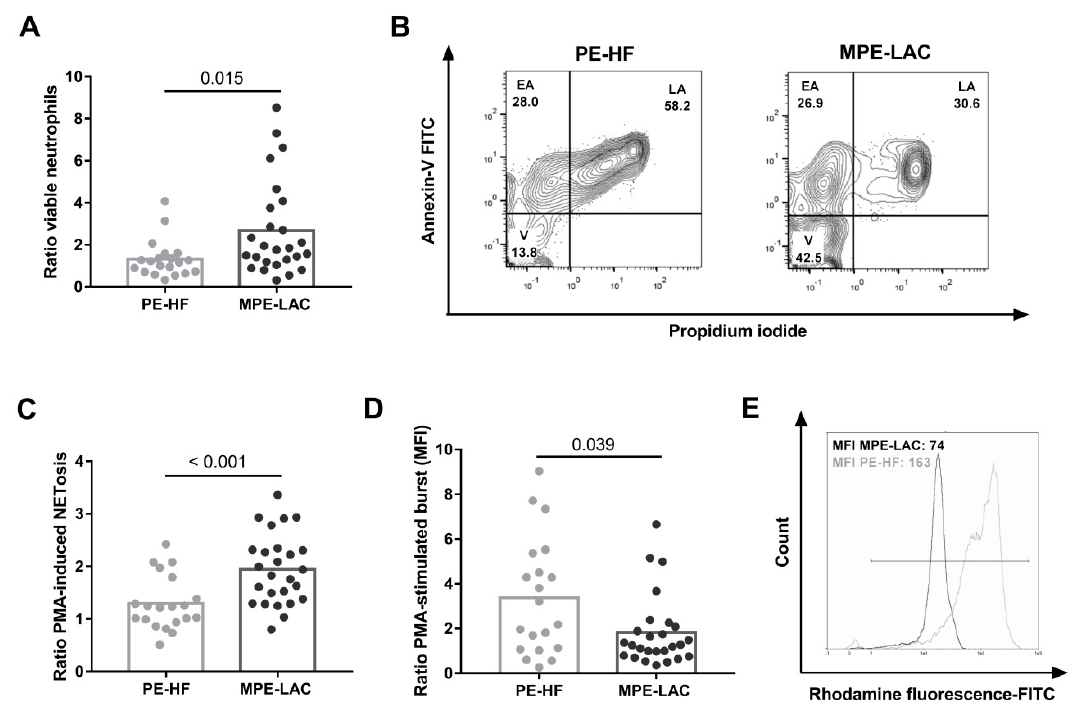
Figure 2. Effect of cell-free pleural fluid on neutrophil viability, NETosis, and oxidative burst. Healthy neutrophils were cultured in the presence of pleural fluids (25% of volume). Viability and oxidative burst capacity were determined by flow cytometry and NET formation was measured by fluorescence. ( A ) The viability of neutrophils in the presence of pleural effusions from heart failure (PE-HF) ( n = 20) and lung adenocarcinoma (MPE-LAC) ( n = 26). Data were expressed as ratios cal- culated by dividing PE-HF or MPE-LAC values by their respective medium values. ( B ) Representa- tive flow cytometry plots of apoptosis assay of neutrophils cultured with cf-PE-HF and cf-MPE- LAC. Quadrants are V for viable cells, EA for early apoptosis, and LA for late apoptotic cells. ( C ) and ( D ) Capacity of PE-HF ( n = 20) and MPE-LAC ( n = 26) to trigger NET formation and oxidative burst, respectively, under PMA-stimulation conditions. Data were expressed as ratios calculated by dividing PE-HF or MPE-LAC values by their respective control medium values. ( E ) Representative flow cytometry histograms of ROS production of neutrophils cultured in the presence of cf-PE-HF (grey line) or MPE-LAC (black line). The Mann–Whitney test was used for statistical analyses. P -values are shown in the graphs.